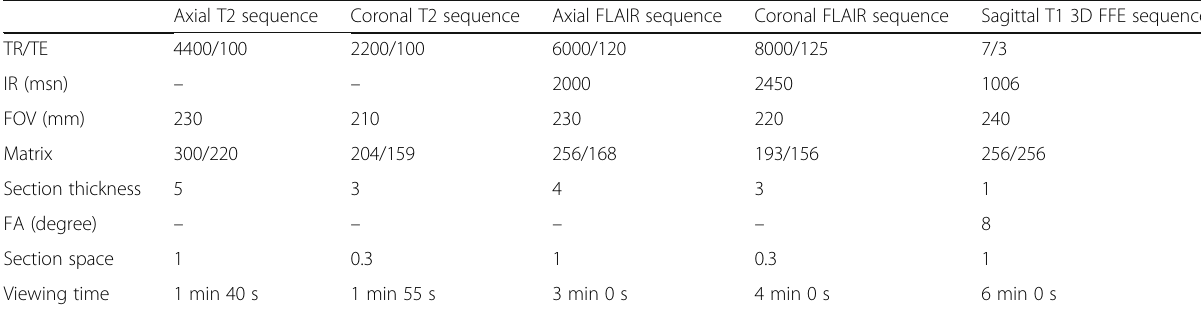
Table 3 Parameters used in 1.5-Tesla MRI